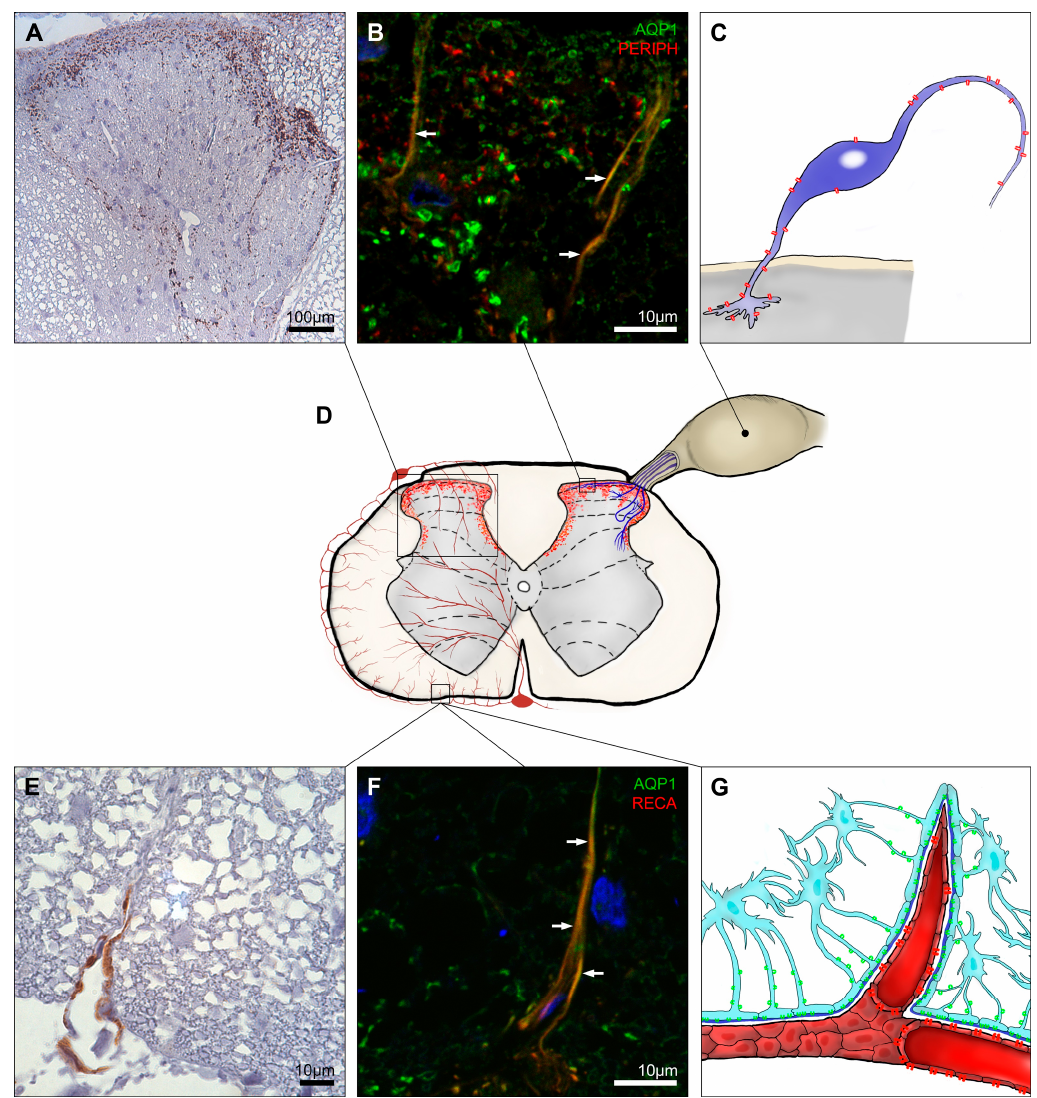
Figure 1. AQP1 expression in the spinal cord. AQP1 was strongly expressed at laminae I and II of the dorsal horn with decreasing signal intensity at the medial edges of dorsal horns up to lamina V ( A , D ); A fraction of the AQP1 signal belonged to unmyelinated neuronal cells ( B ) protruding from dorsal root ganglion to the superficial laminae of dorsal horns which axons build up peripheral sensory fibers ( C ); Illustration of AQP1 expression in the spinal cord cross-section ( D ); AQP1 labeling in the white matter was rather infrequent and found in proximity to the glia limitans ( E ) most likely belonging to small arterioles furcating from the arterial vasocorona ( F , G ). Panels A , B , E and F are modified from Oklinski et al. [21]. The blue signal in panels B and F represents 4 ′ ,6-diamidino-2-phenylindole (DAPI) staining of the nuclei; AQP1, aquaporin 1; PERIPH, peripherin and RECA, rat endothelial cell antigen-1. Colocalization indicated by arrows. AQP1 is indicated in red on panels C , D and G . AQP4 is drawn in green on panel G . White arrows in B and F .